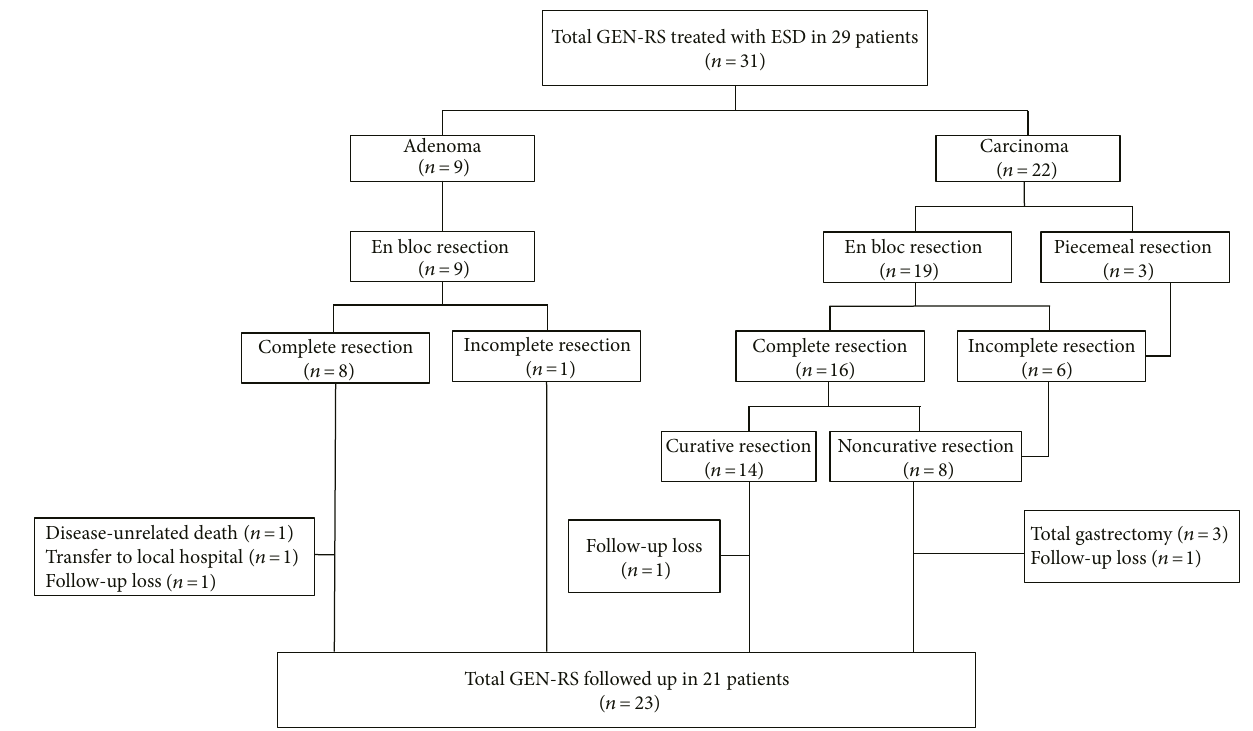
Figure 2: Flowchart of the patients included in the